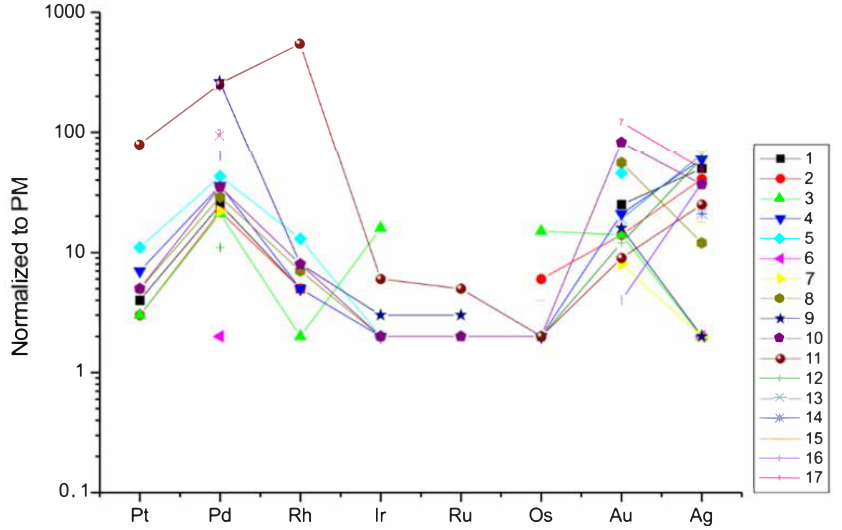
Figure 3. Primitive mantle-normalized [21] spidergram of the platinum-group elements (PGE), Ag and Au content in the rocks of the Guli Intrusion (for the description of the numbers, see Table 3). The maximum content of PGE (mainly due to palladium) in the rocks of the differ- entiated complex was identified in phlogopite porphyrites (1.9 ppm), agpaitic